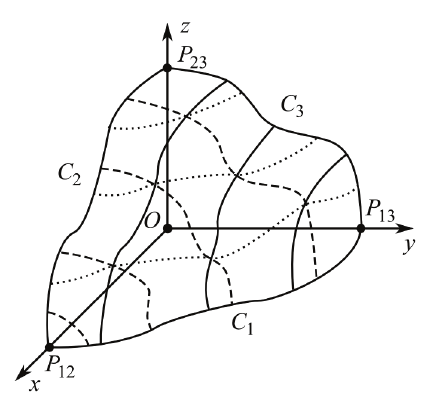
Figure 5. “Pulling” of all 3